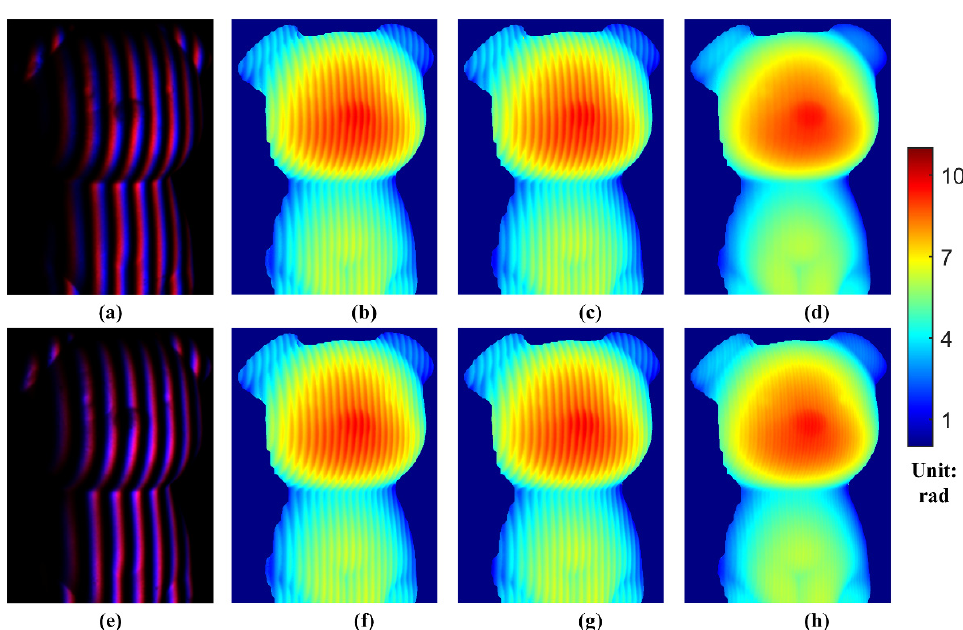
Figure 7. One cross section of the recovered absolute phases of the sphere.